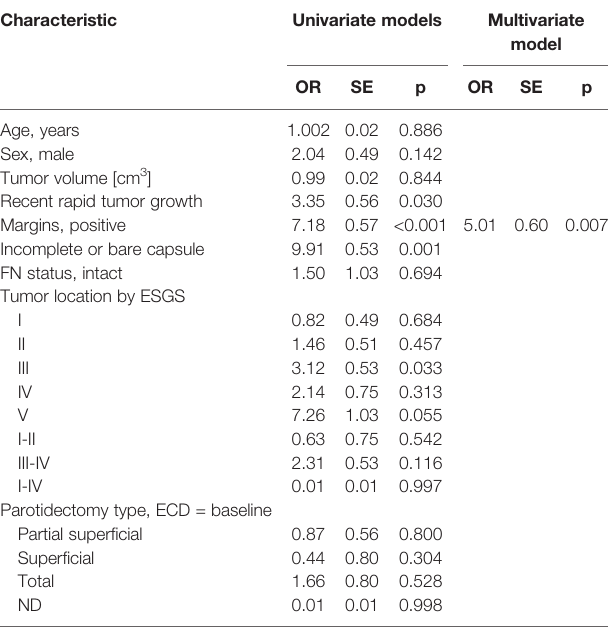
TABLE 2 | Cox regression model for